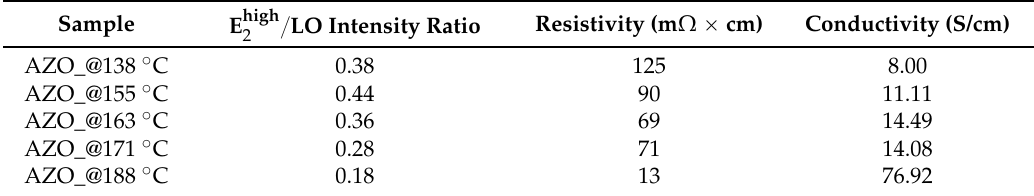
Table 1. Micro-Raman and resistivity